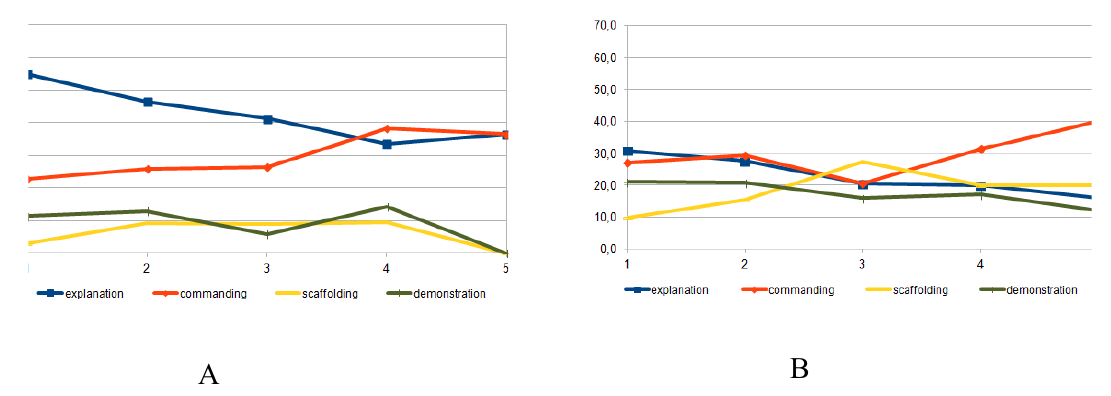
Figure 4. The most frequent techniques of non-user tutors who had prepared (NY)